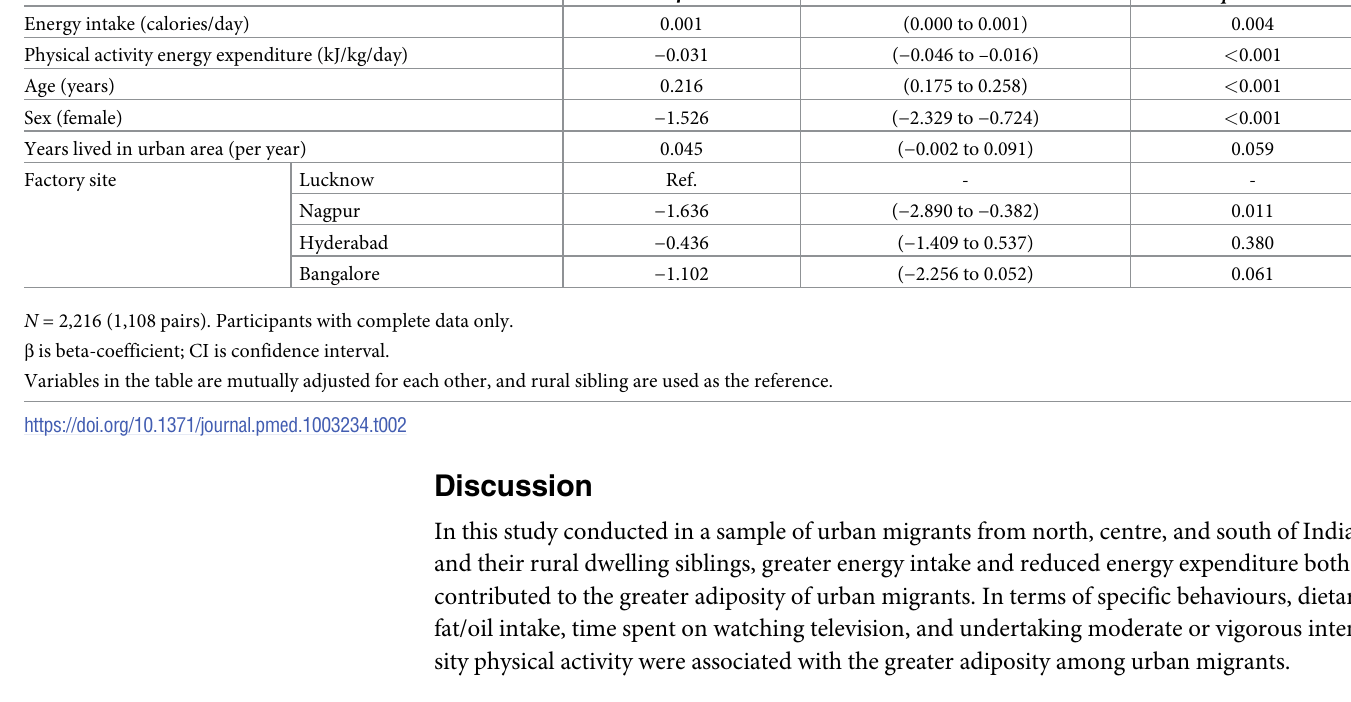
Table 2. Multivariable model for association of difference in energy intake and energy expenditure on physical activity on the difference in % body fat between urban and rural siblings in the Indian Migration Study, 2005–2007. Variable β